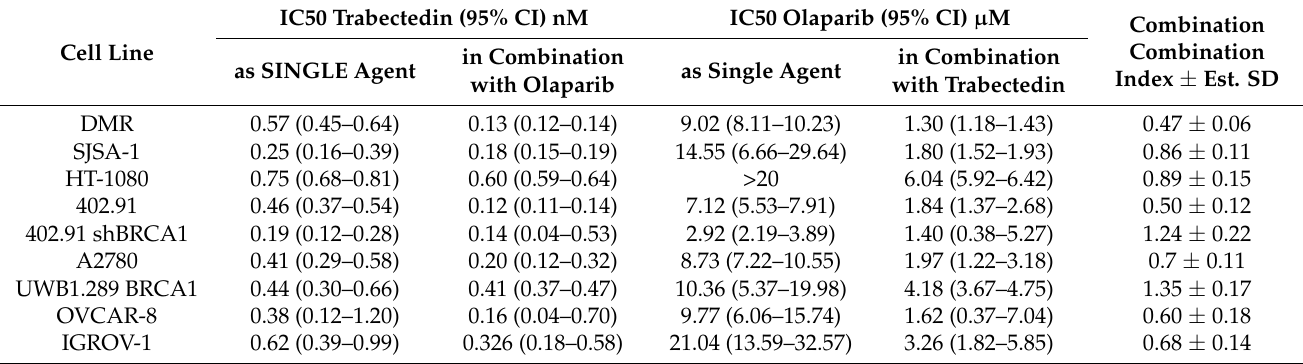
Table 1. Concentration inhibiting 50% of cell viability (IC50) and 95% confidence intervals (95%CI).